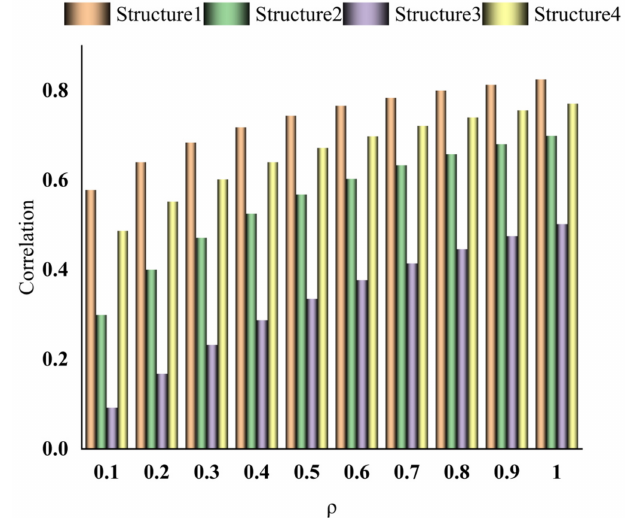
Figure 9. Correlation at different resolution coefficients.